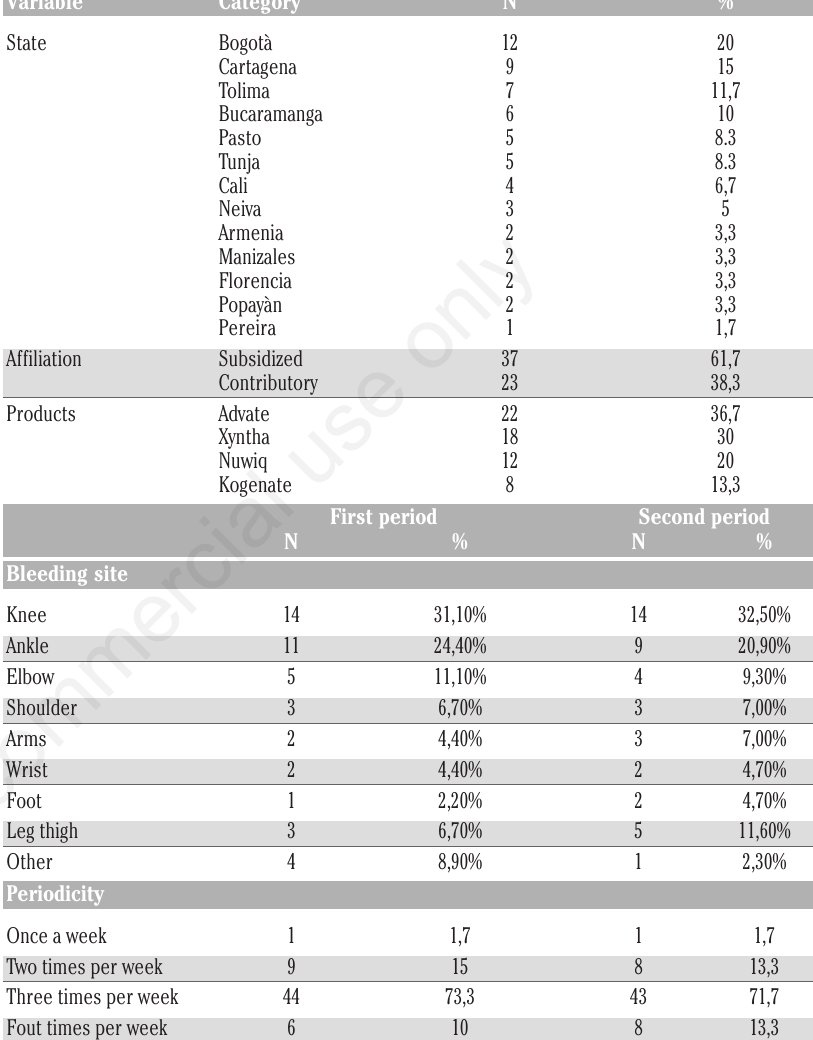
Table 1. Description of the population (qualitative